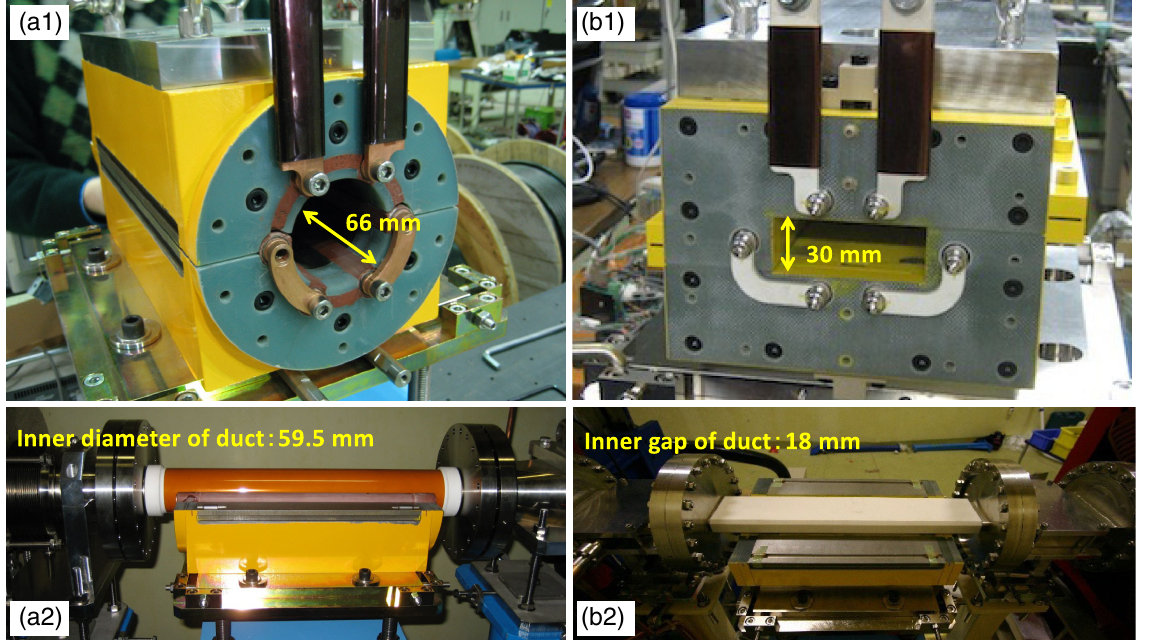
FIG. 2. Photographs of the magnets and ceramic chambers of PSM1 (A-1, A-2) and PSM2 (B-1,